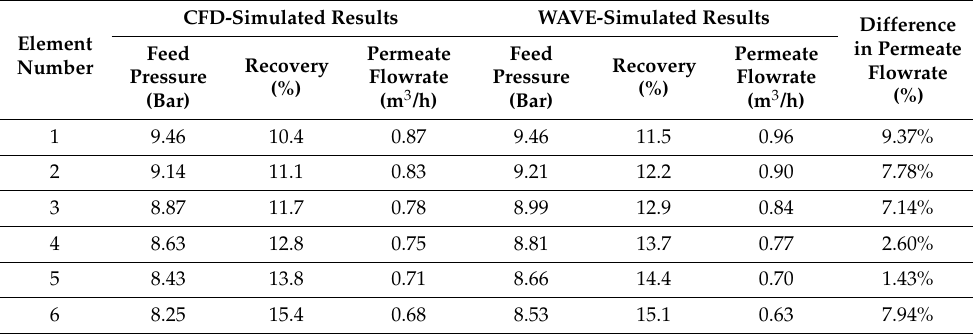
Table 3. Comparison of results obtained from CFD and